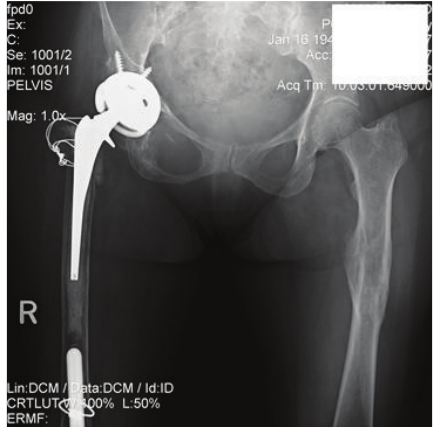
Figure 10: 5 months after operation.